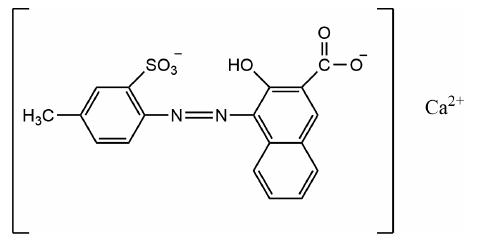
Figure 5. Structure of C 18 H 12 N 2 O 6 SCa.